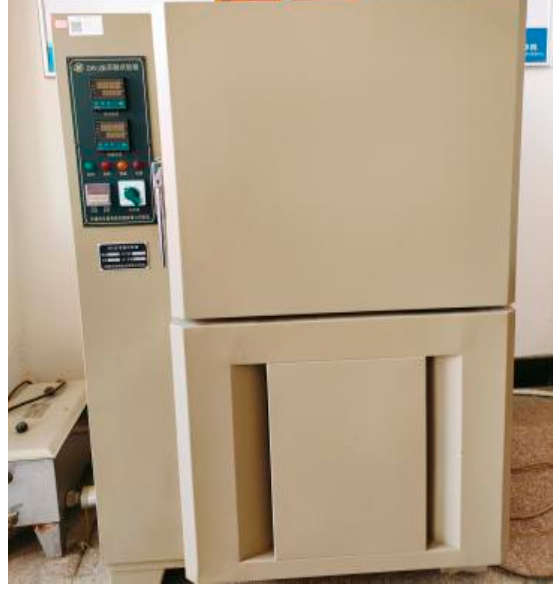
Figure 1. Freeze–thaw test